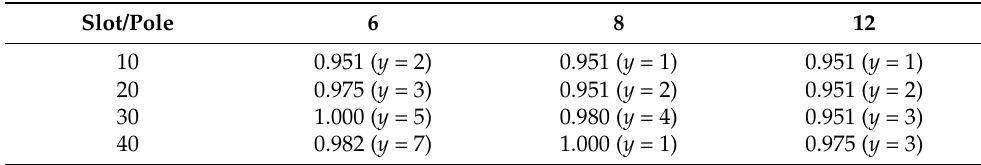
Table 1. Winding coefficient under different slot/pole combination.